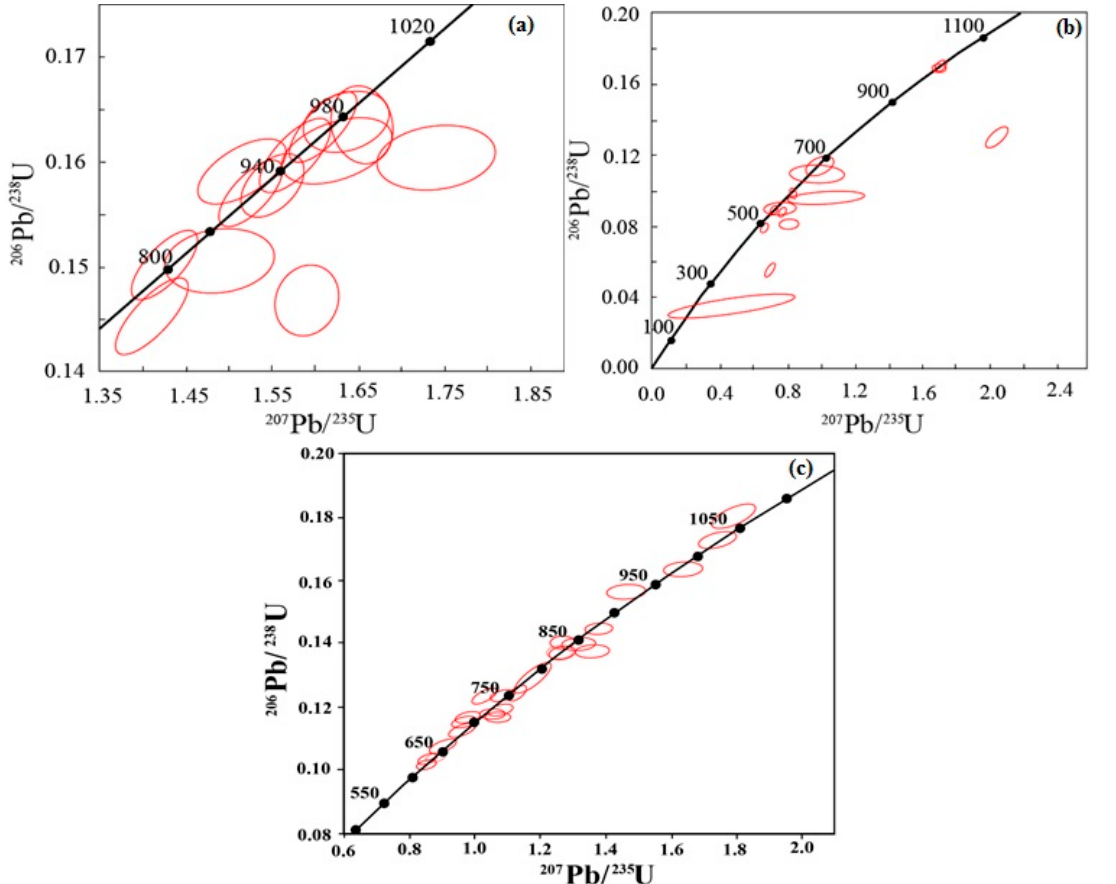
Figure 6. U-Pb zircon concordia plot and age determination for ( a ) Araru black to whitish gneiss; ( b ) from Araru whitish-grey gneiss, and ( c ) from Mboifong migmatite.